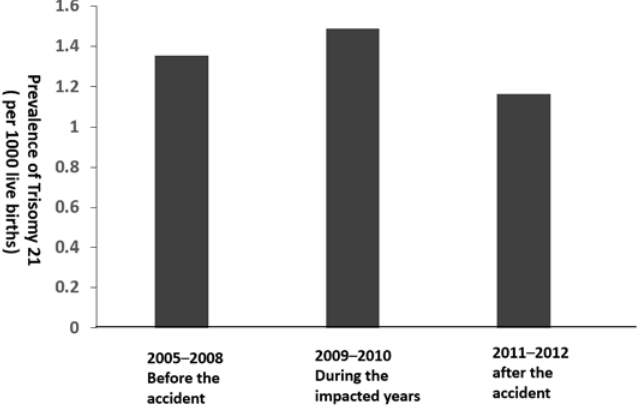
Figure 4. Prevalence of Trisomy 21 before, during, and after the fire accident in Brazos County, Texas.